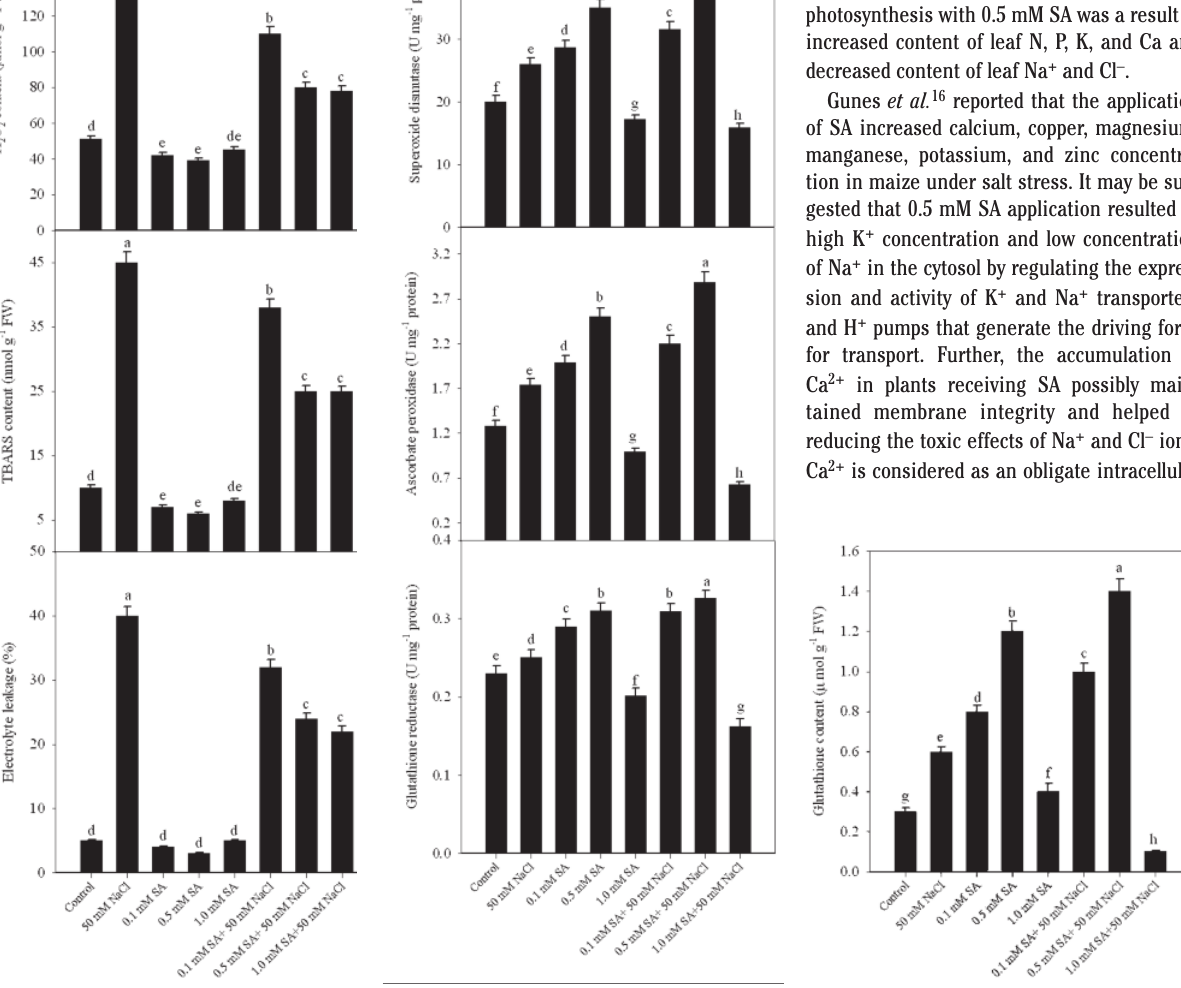
Figure 4. Effect of salicylic acid spray at 15 Figure 3. Effect of salicylic acid spray at 15 days after sowing (DAS) on superoxide dis- days after sowing (DAS) on H O content, mutase, ascorbate peroxidase, and glu- 2 2 TBARS content, and electrolyte leakage of tathione reductase of mungbean ( Vigna radiata L.) plants grown with 0 or 50 mM mungbean ( Vigna radiata L.) plants grown with 0 or 50 mM NaCl at 30 DAS. Values NaCl at 30 DAS. Values are mean±SE. Data are mean±SE. Data labeled by the same let- labeled by the same letter did not differ sig- ter did not differ significantly at P<0.05. nificantly at P<0.05.